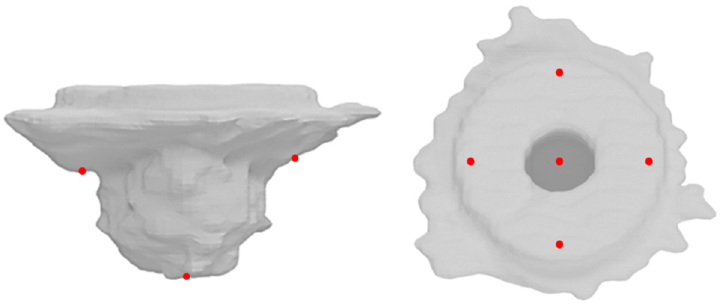
Figure 7. Defined measurement points to determine the cement penetration in Group 2-A and 2-B .